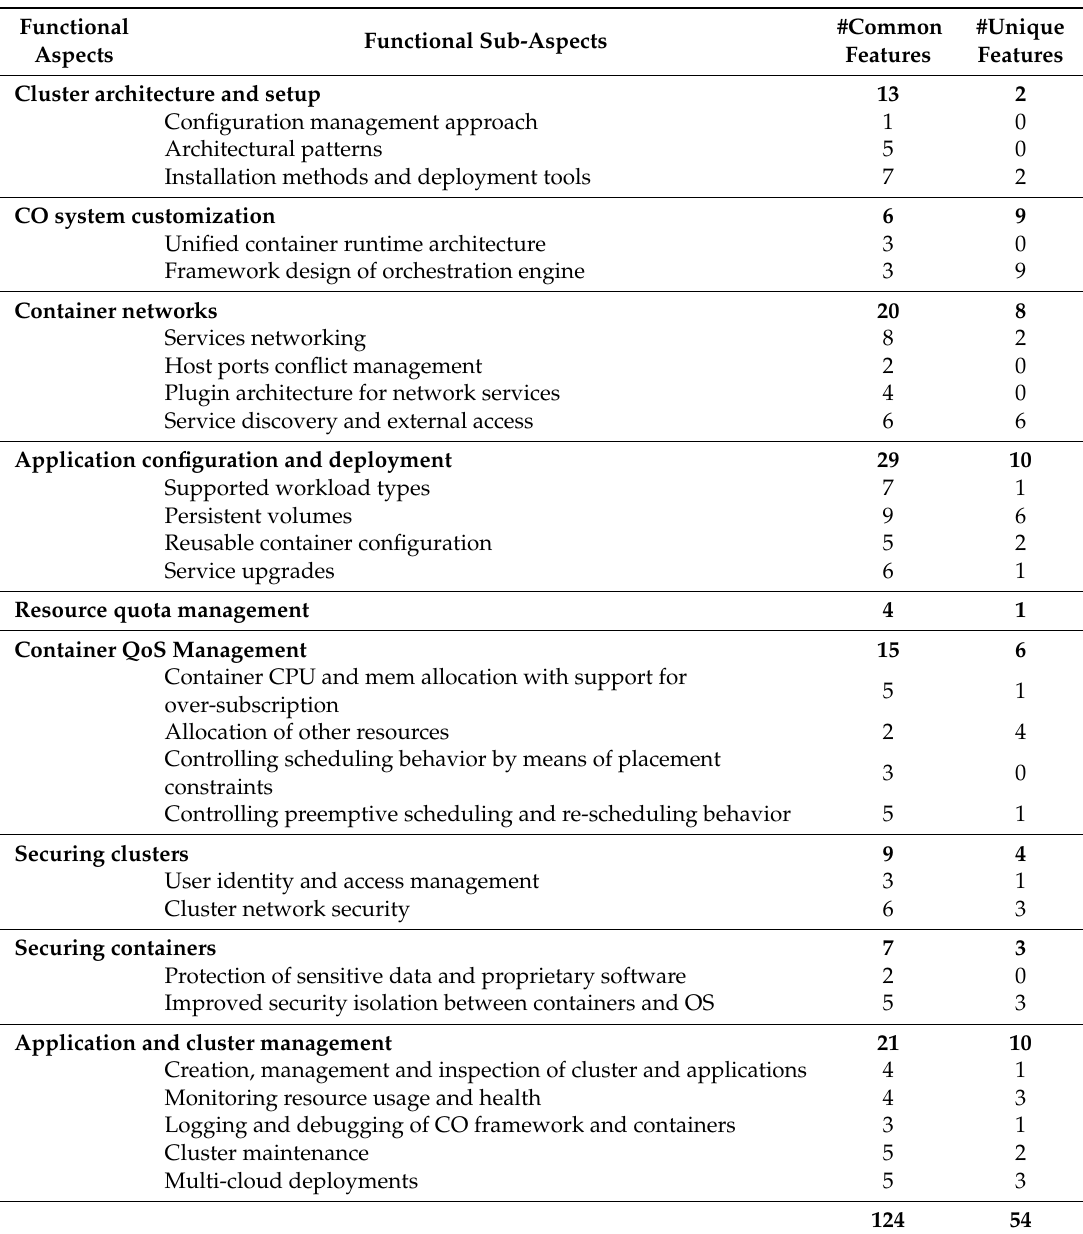
Table 1. Overview of functional aspects and sub-aspects and their number of common and unique